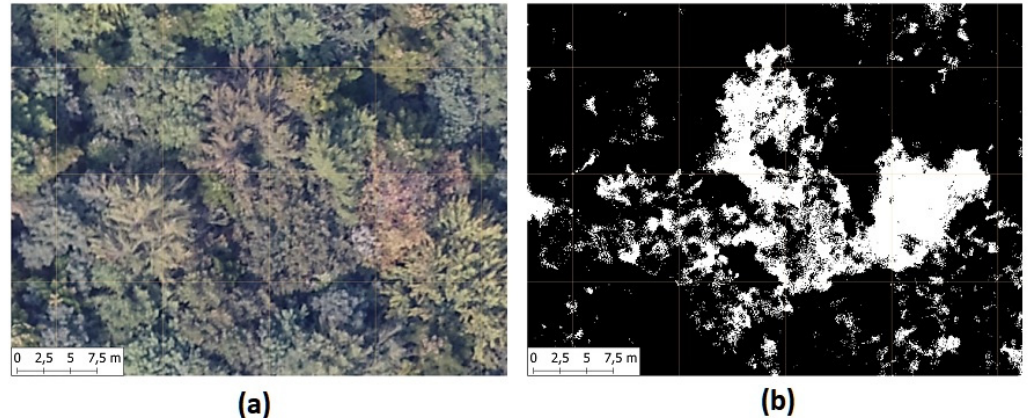
Figure 10. Example of false canopy gap creation from UAV RGB images over the damaged trees with crown discoloration. ( a ) UAV image segment of trees with the damaged canopy; ( b ) related UAV mask with false open spaces presented in white.